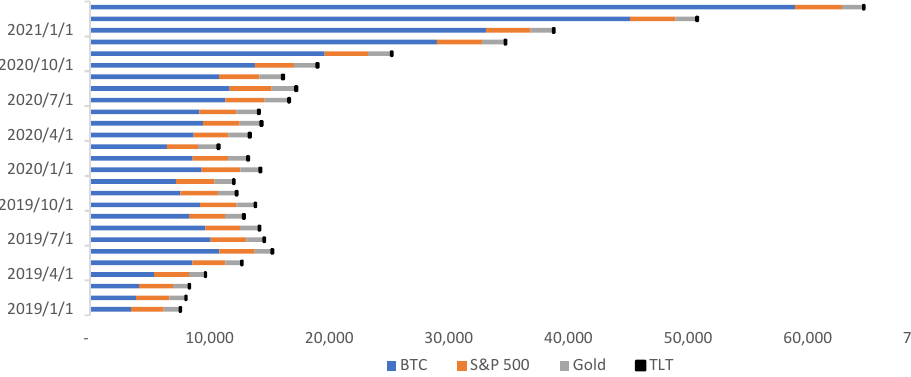
Figure 2. Monthly return distribution between 15 September 2014 to 15 September 2021.